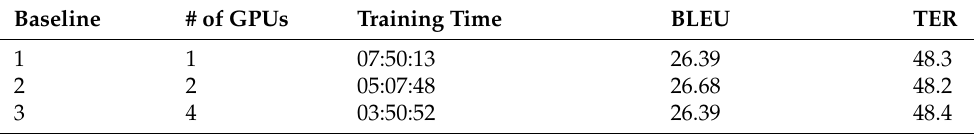
Table 3. Comparison of the performance of the baseline models.